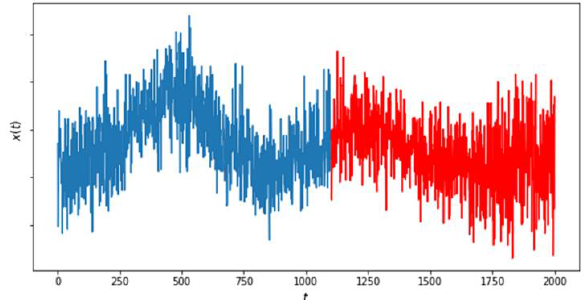
Figure 18. AG mill power draw gradually transforming from non-fault data (blue) into white noise